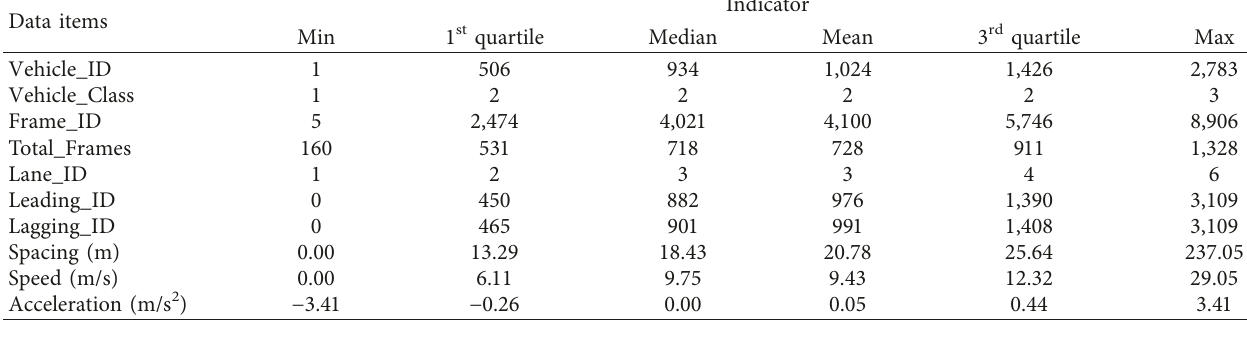
Table 1: Summary statistics of vehicle trajectory data for calibrating the proposed model.